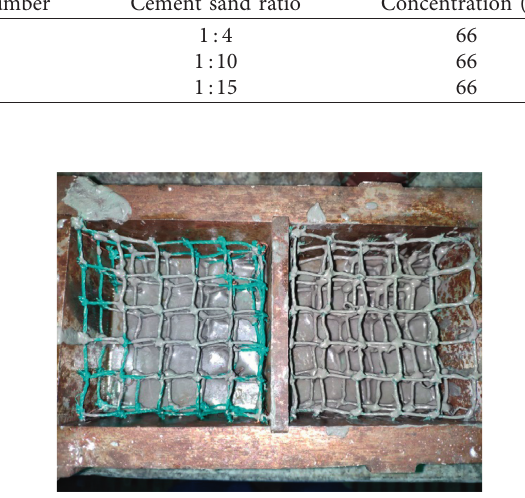
Figure 1: 3D flexible grid reinforcement of filling body.